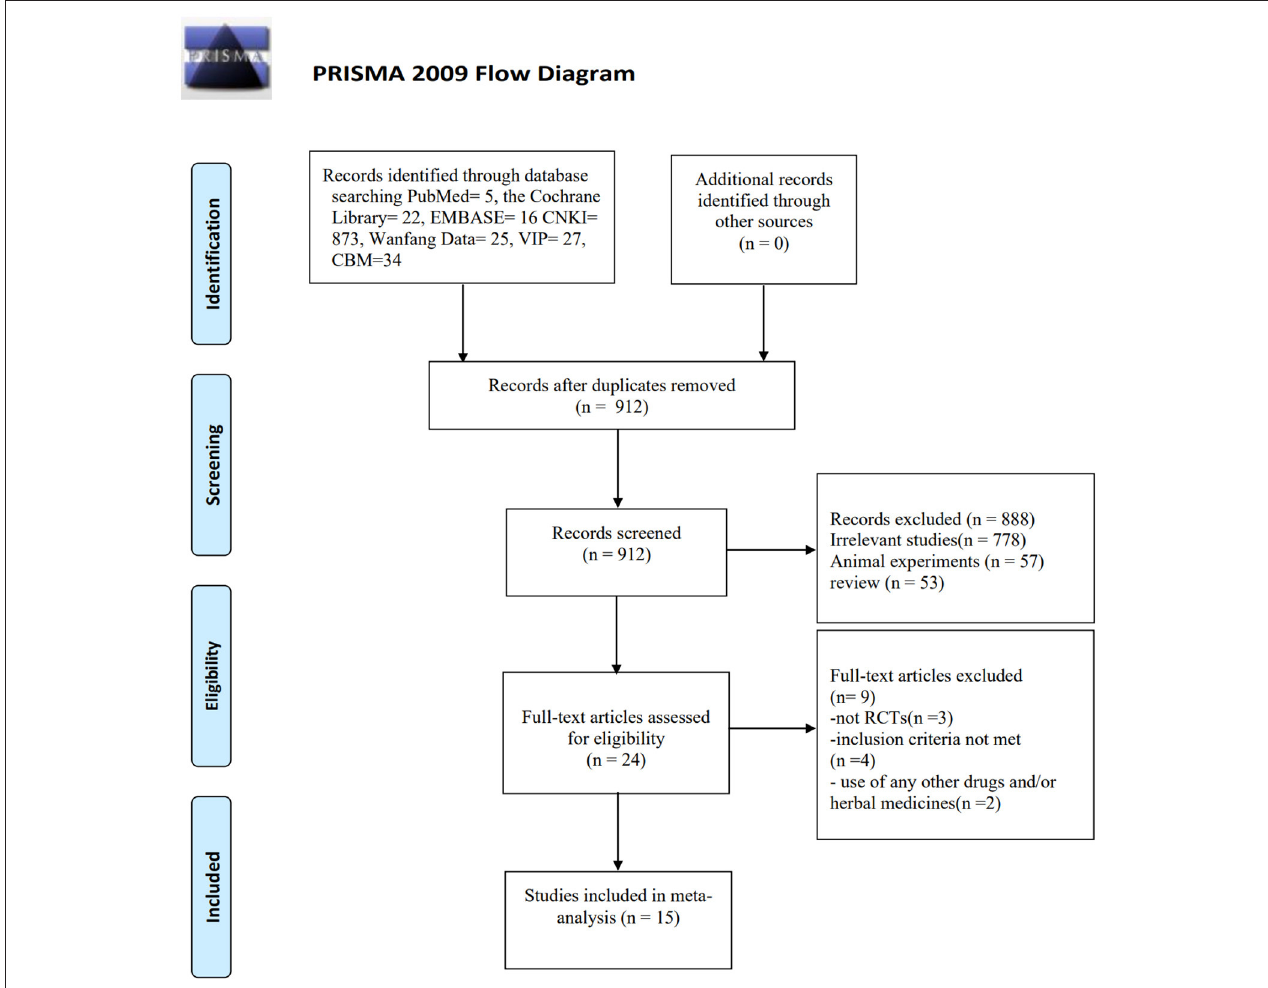
FIGURE 1 | Flowchart of the process for literature